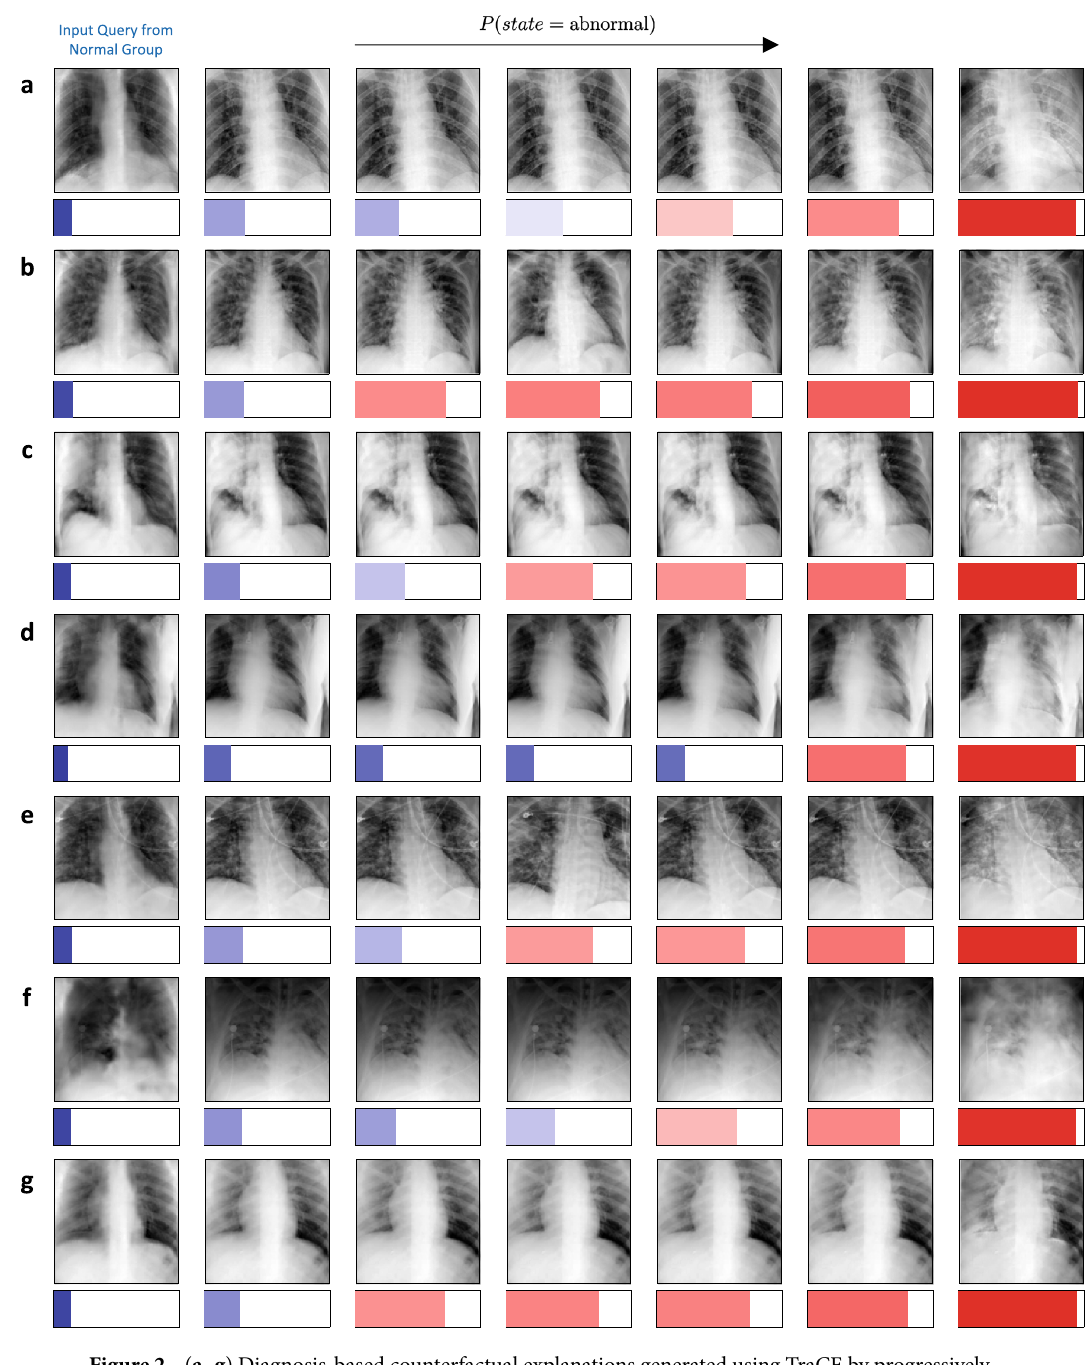
Figure 2. ( a – g ) Diagnosis-based counterfactual explanations generated using TraCE by progressively introducing relevant patterns into different query images (first image in each row) of healthy subjects to increase the likelihood of being assigned to the abnormal group ( P ( state = abnormal ) ). ( h – n ) Diagnosis-based counterfactual explanations generated using TraCE by progressively introducing relevant patterns into different query images (first image in each row) of healthy subjects to increase the likelihood of being assigned to the abnormal group ( P ( state = abnormal )